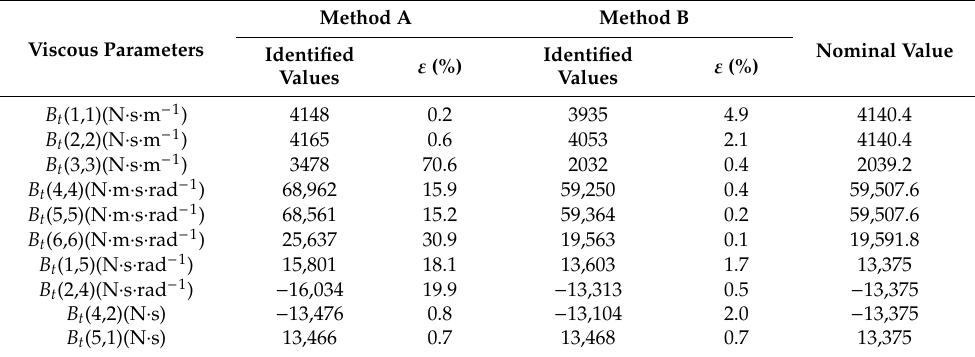
Table 5. Identification results of the viscous parameters of the Simulink ® model with 5 N Coulomb